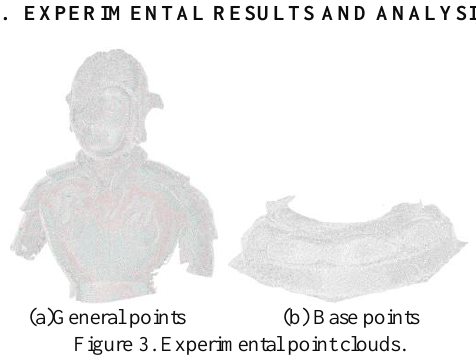
Figure 3. Experimental point